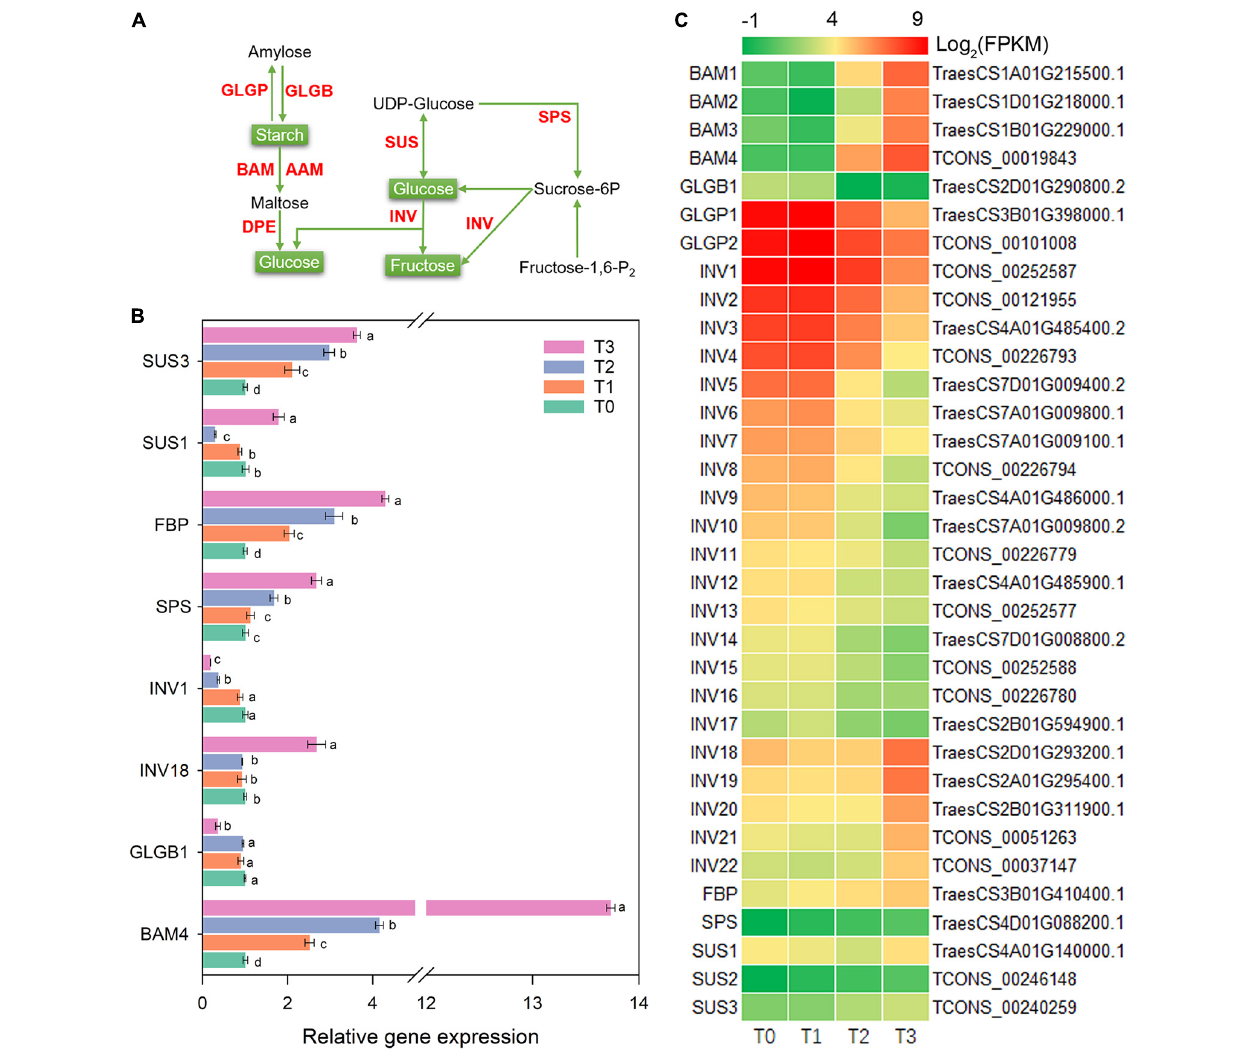
(GALA), inositol 3- α -galactosyltransferase (GOLS), and raffinose synthase (RFS) was affected during the regeneration of seedlings ( Figure 6C ). The expression of RFS1 and GOLS1 increased significantly within 72 h after mowing ( Figure 6B